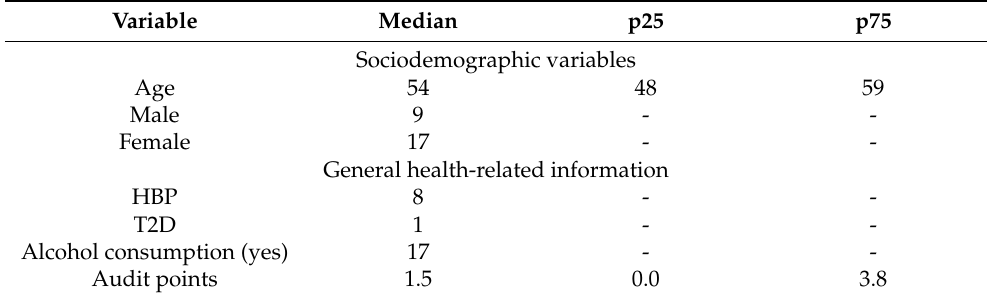
Table 1. Sociodemographic variables and general health-related information of